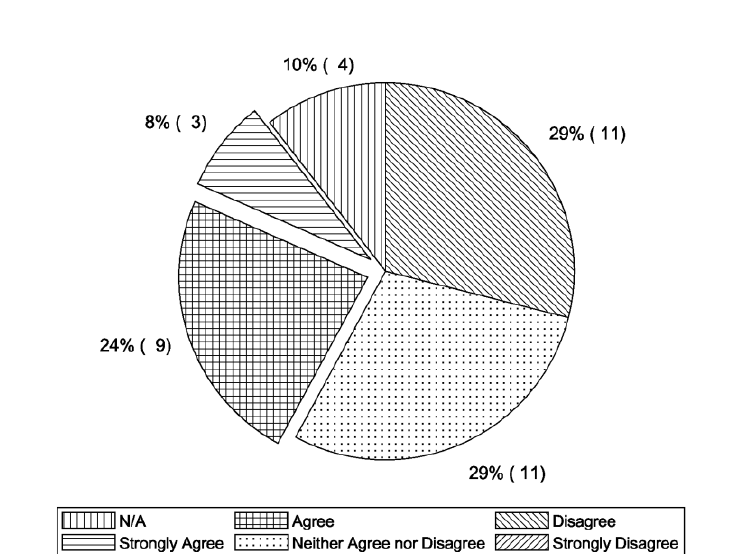
Fig. 14. Projects affect students to change the engineering major that they chose before taking this